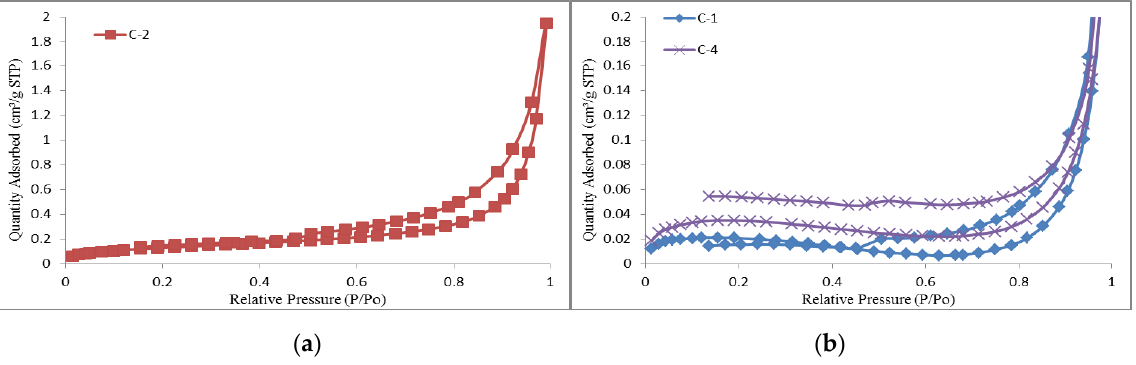
Figure 12. N 2 adsorption–desorption curves of high-rank coal samples of C-1, C-2, and C-4. ( a ) N 2 adsorption–desorption curve of sample C-2. ( b ) N 2 adsorption–desorption curves of sample C-1 and C-4.